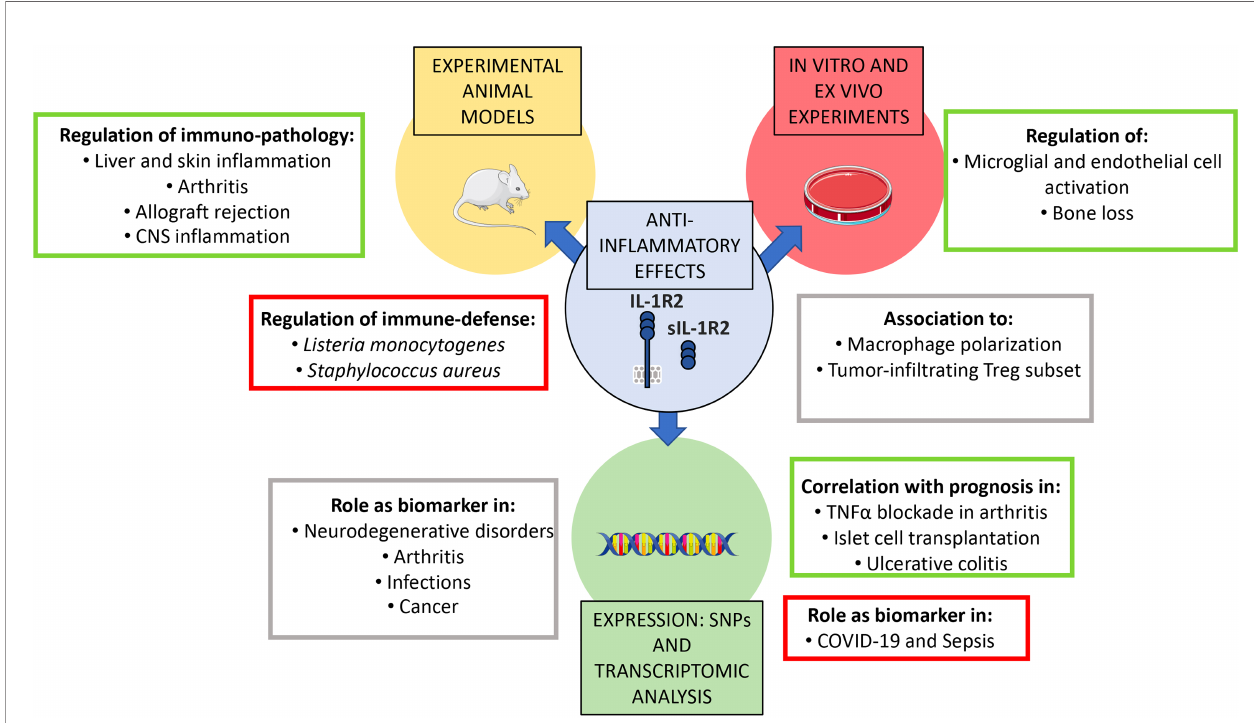
FIGURE 2 | Roles of IL-1R2 in pathology. Experimental animal models, in vitro and ex vivo experiments, as well as scRNA-sequencing and transcriptomic analysis demonstrated the role of IL-1R2 as a key modulator and as a biomarker of acute and chronic in fl ammation in several pathological contexts. In particular, IL-1R2 plays a non-redundant role in regulating macrophage polarization, anti-microbial response and infections (such as sepsis and COVID-19), sterile in fl ammation (such as arthritis, liver, skin and CNS in fl ammation), neurodegenerative disorders and cancer. Full-length and sIL-1R2 have also been proposed as novel biomarkers for prognosis in infectious diseases, neurodegenerative disorders, rheumatoid arthritis, ulcerative colitis and